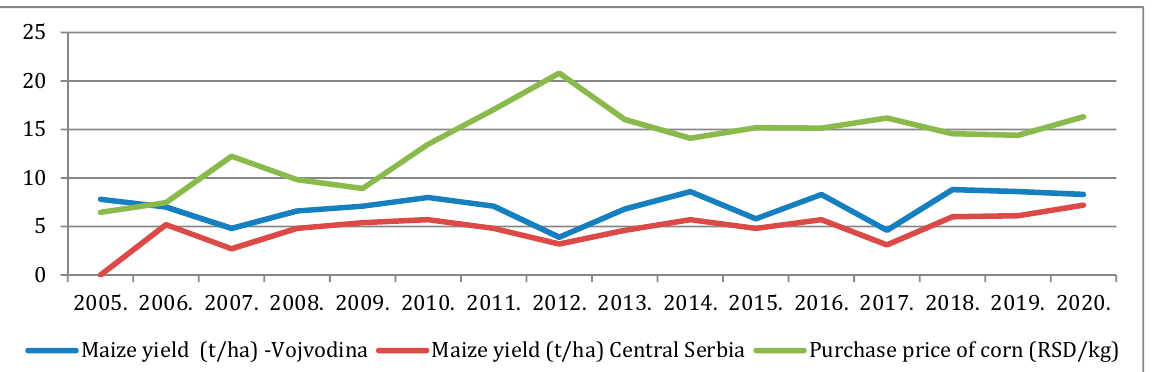
Figure 11. Yield and purchase price of maize in the Republic of Serbia for the period 2005–2020.